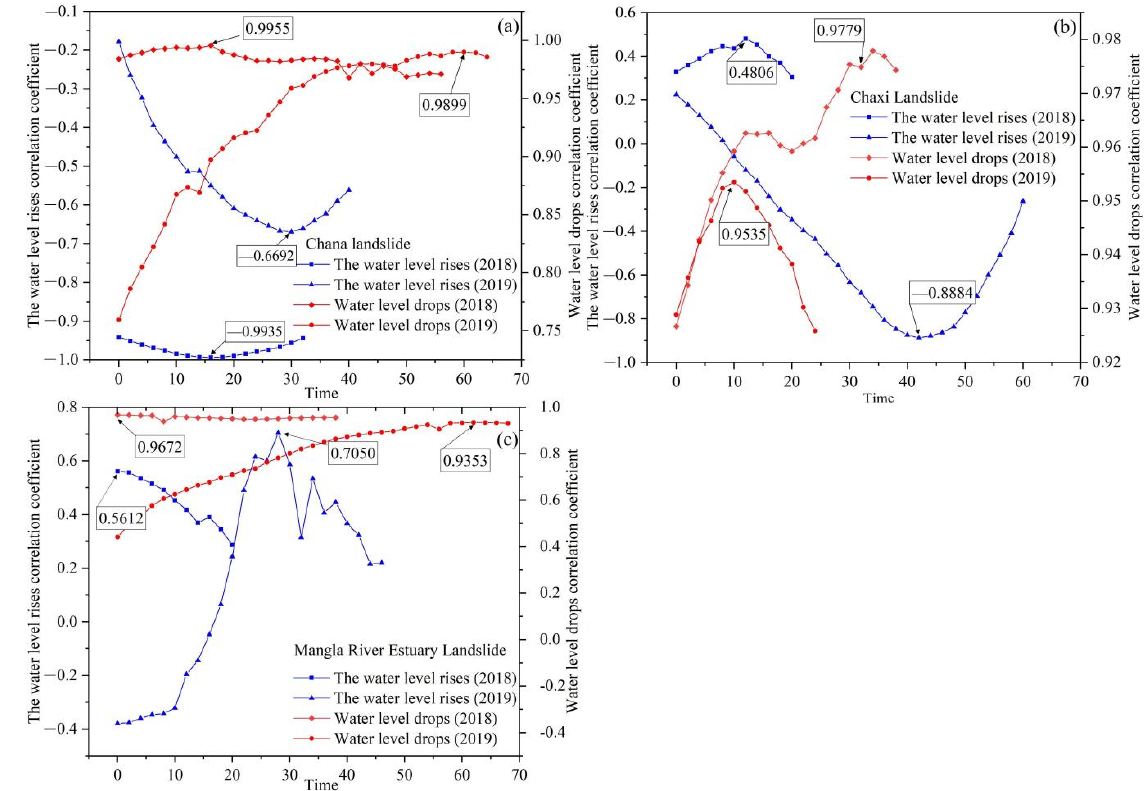
Figure 21. Correlation between landslide displacement and water level change. ( a ) Correlation coefficient between the displacement of the Chana landslide and the water level. ( b ) Correlation coefficient between the displacement of the Chaxi landslide and the water level fluctuation. ( c ) Indicates the correlation coefficient between the displacement of the Mangla River estuary slope and the water level.